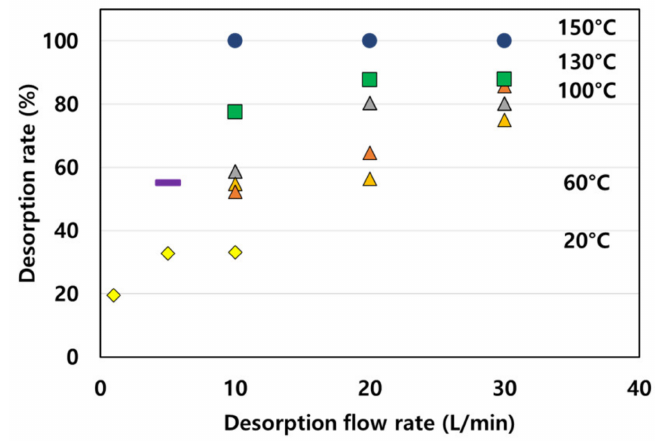
Figure 7. Desorption rate based on desorption flow rate and desorption temperature ( • 150 ◦ C, (cid:4) 130 ◦ C, (cid:78) 100 ◦ C, – 60 ◦ C, and (cid:117) 20 ◦